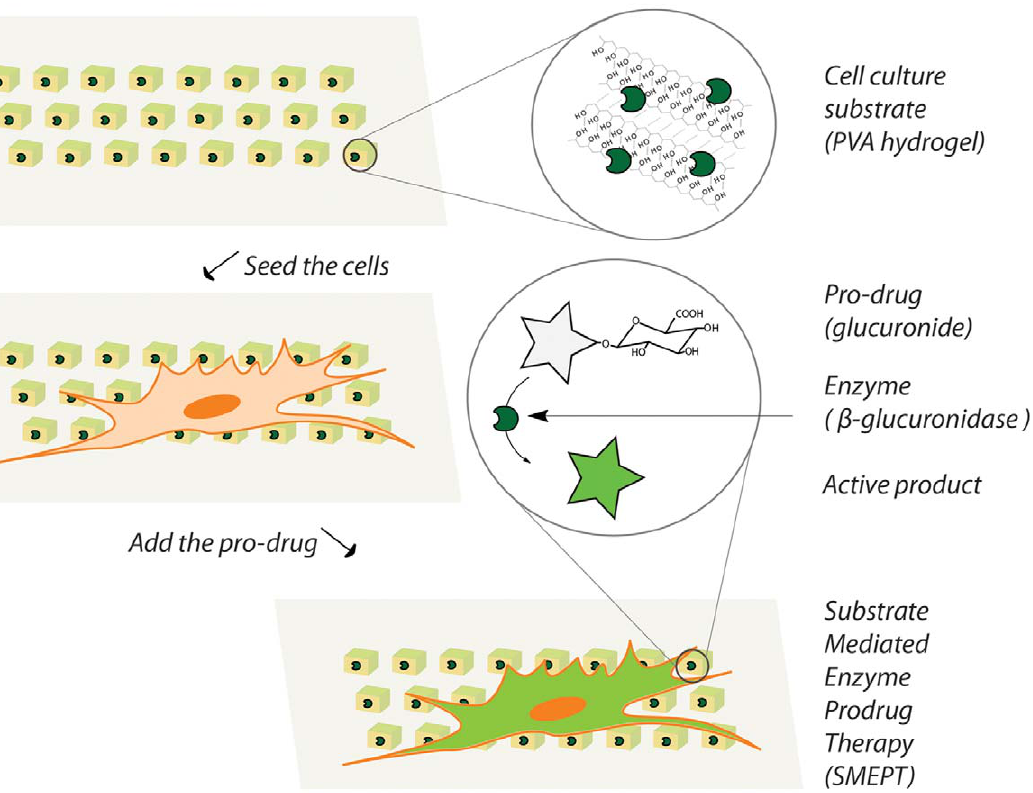
Figure 1. Schematic illustration of the concept of Substrate Mediated Enzyme Prodrug Therapy (SMEPT). A cell culture substrate contains an enzyme for conversion of an inactive prodrug into an active product which is then internalized by the adhering cells or adjacent tissues. SMEPT affords both, an amplification of the deliverable payload and an interactive adjustment of the dose and the rate of drug release.